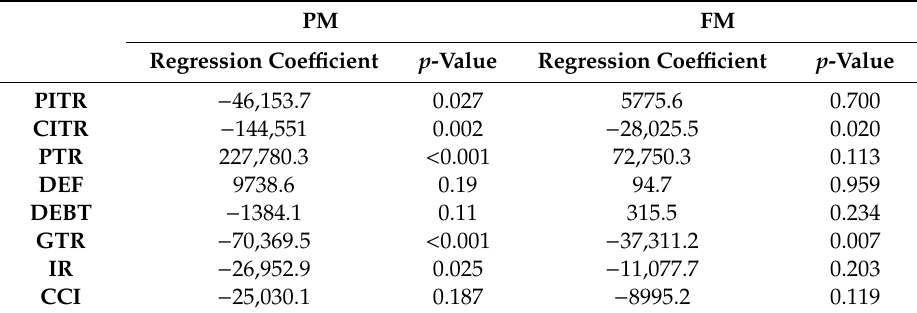
Table 1. Estimated models for the first group of countries.